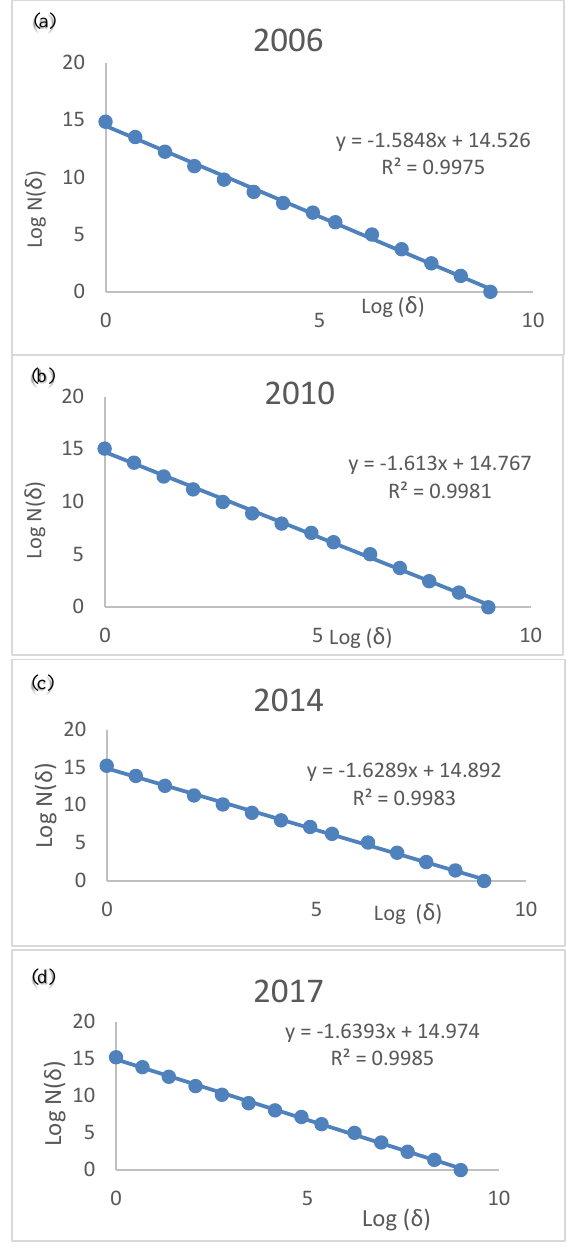
Figure6. Fractal dimension of urban area from year (a) 2006, (b) 2010, (c) 2014, (d) 2017